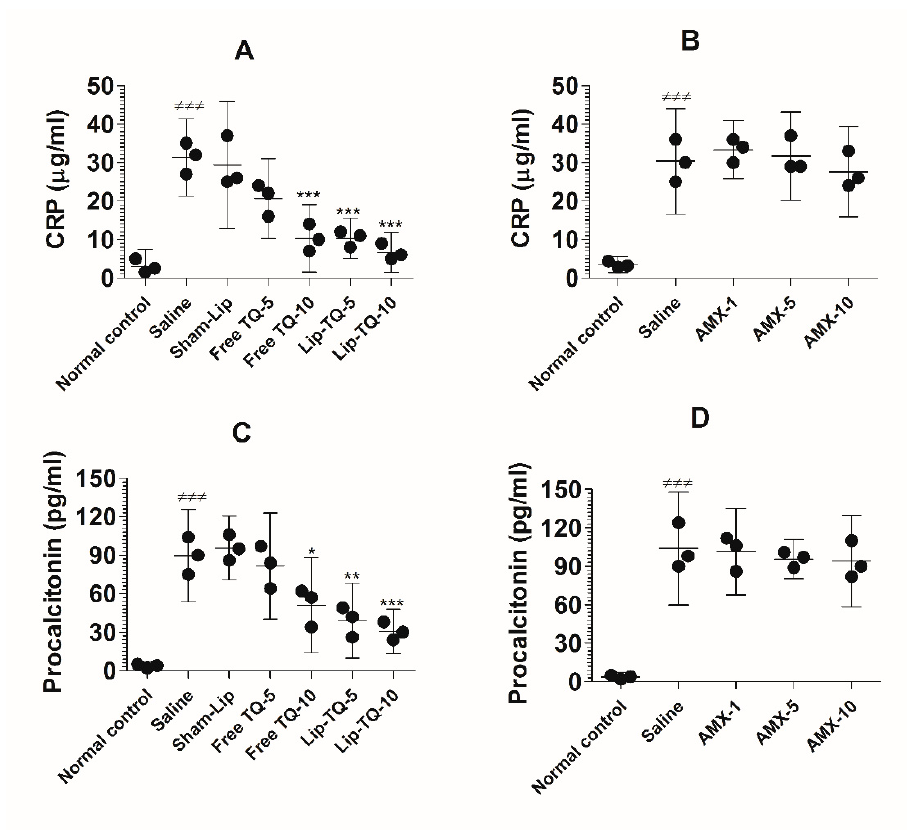
Figure 11. Treatment with Lip-TQ, but not with AMX, alleviated the parameters of the CRP and PCT in the mice infected with drug-resistant A. baumannii . On day 5 post-treatment, the blood was sampled from three mice and the levels of the CRP and PCT were analyzed. ( A ) The CRP in the free TQ- or Lip-TQ-treated mice, ( B ) the CRP in the AMX-treated mice, ( C ) PCT in the free TQ- or Lip-TQ-treated mice, ( D ) PCT in the AMX-treated mice. The data are represented as the means ± SD of three independent experiments. ≠≠≠ p < 0.001. Normal control vs. saline-treated mice, * p < 0.05, ** p < 0.001, *** p < 0.001. Saline vs. free TQ or Lip-TQ treatment groups.